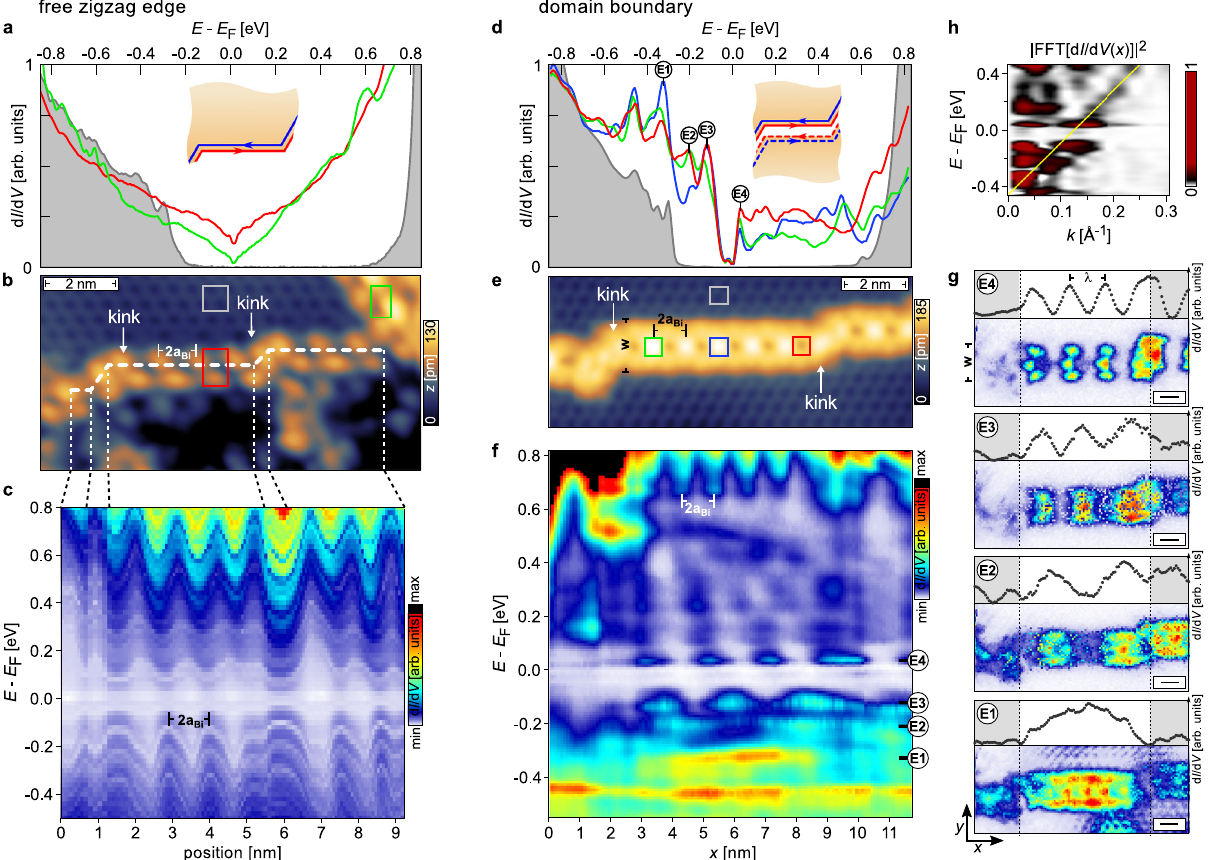
Fig. 3 Electronic properties of free zigzag edge states vs. DB states. a STS d I /d V spectra on/off a free bismuthene zigzag edge, measured at positions marked in b . The bulk spectrum (gray) shows an insulating gap. Spectra taken on the edge (red, green) verify the existence of a metallic edge channel smoothly fi lling the gap. b Constant-current STM topography of a free zigzag edge ( V = − 1.2 V, I = 20pA). The edge is divided into straight edge segments of set set variable length separated by kinks (indicated by white-dashed line). Colored squares: positions, where the spectra in a are taken. c Energy-dependent d I /d V signal versus position along the white-dashed path in b . The periodic modulation corresponds to the structural edge periodicity 2 a Bi . d d I /d V spectra on/off a bismuthene DB, at positions marked in e . The bulk spectrum (gray) agrees with the one in a . The spectra taken on the DB (green, blue, red) (nearly) fi ll the gap and are characterized by the presence of intense peaks at discrete energies, in remarkable contrast to the zigzag edge spectra in a . e STM topography of a DB ( V set = − 0.85V, I set = 80pA). Similar to the free zigzag edge, the DB consists of piecewise straight sections connected by kinks. Colored squares: positions, where the spectra in d are taken. f Energy-dependent ( w -integrated) d I /d V signal versus position along the DB in b . Energy-dependent standing wave excitationsare observedatthemarked energies E 1 to E 4 , additional to the structural2 a Bi modulation. g Two-dimensional d I /d V mapsof the DB in e , taken atthe discreteenergies E 1 to E 4 in f . The corresponding ( w -integrated)d I /d V pro fi lealong the DBisshown above eachmap.The modulation wavelength λ isextracted from the d I /d V pro fi les. Gray-shaded regions: guide to the eye to mark the extension of the effective resonator. The scale bar is 1nm. h Power spectrum of the d I /d V map in f . Yellow line: guide to the eye with a slope of 3.6 eV Å